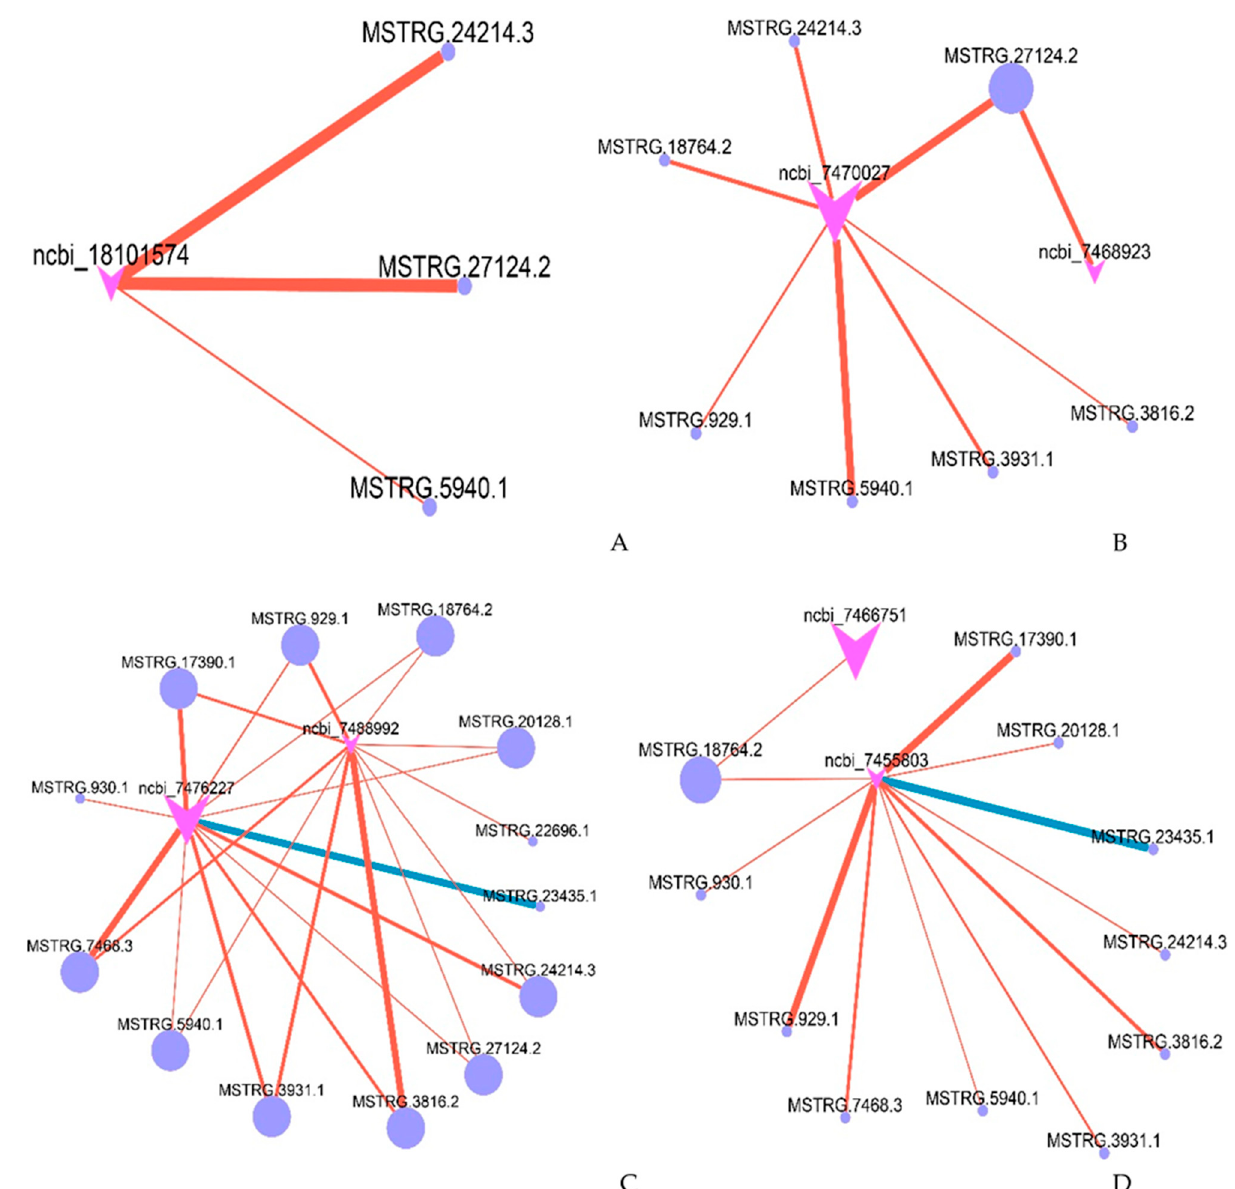
Figure 5. Prediction of DEGs and DELs related to light adaptation ( A ), abiotic stress ( B ), disease resistance ( C ), and growth and development of plants ( D ). Purple dots represent lncRNA. Pink arrows represent target genes. Blue and red lines represent positive and negative correlations, respectively, between the expression levels of lncRNAs and target genes. The line width indicates the degree of di ff erence.